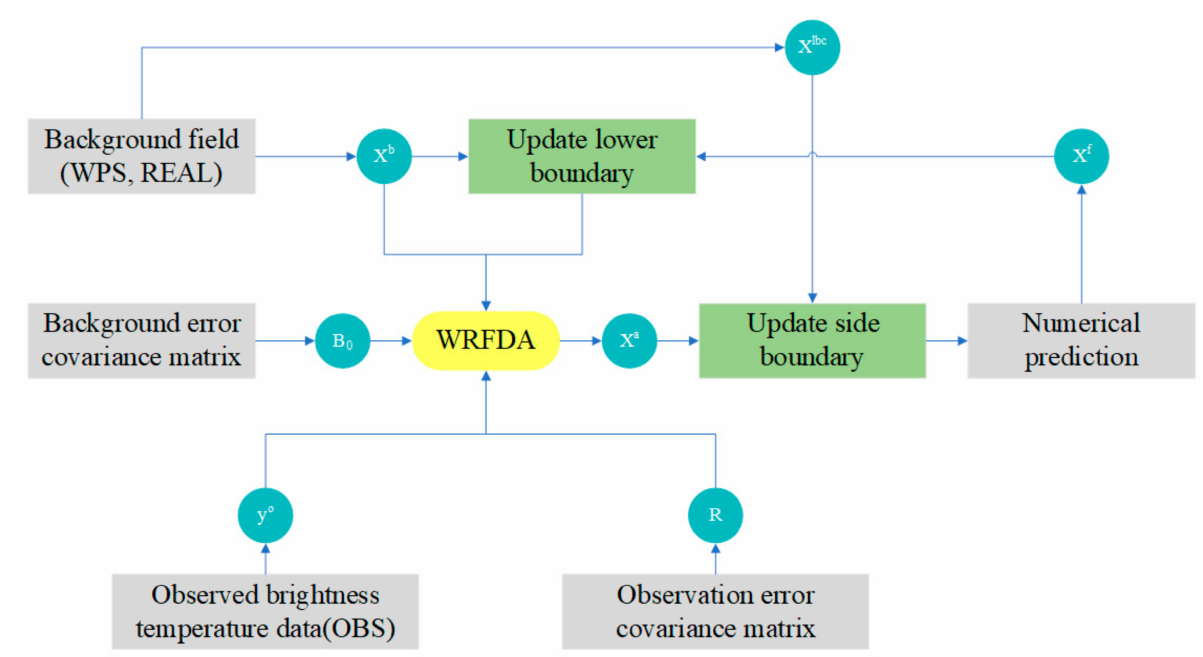
Figure 2. WRFDA-4DVar system framework.